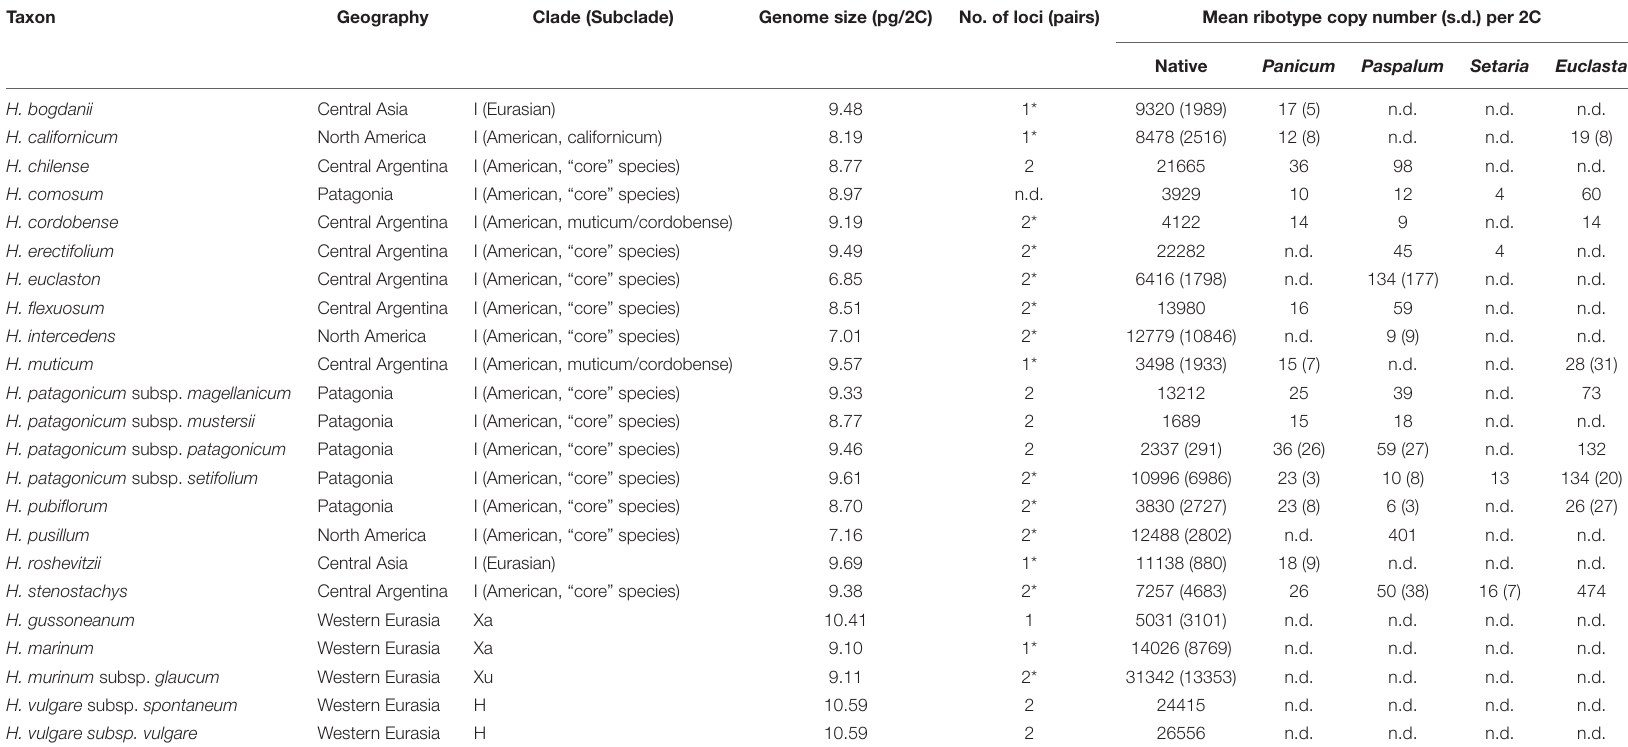
TABLE 1 | Copy numbers of native and foreign ribotypes in Hordeum as estimated using qPCR.